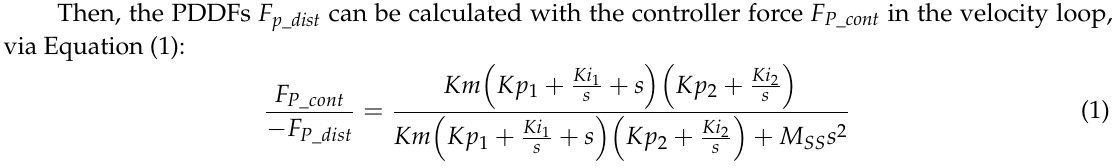
Figure 6. SS controller structure with the PDDFs as input and controller forces as output.